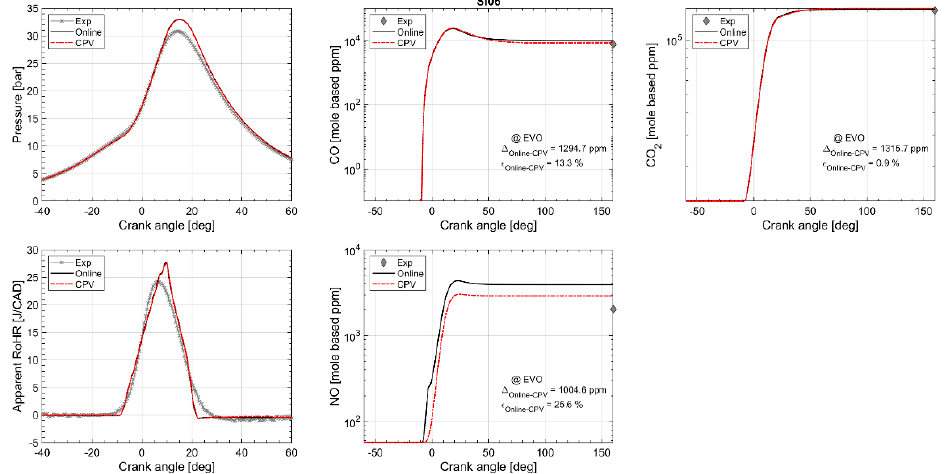
Figure A16. Engine performance and emissions for operating point SI06 (2500 rpm, 5.0 bar IMEP).